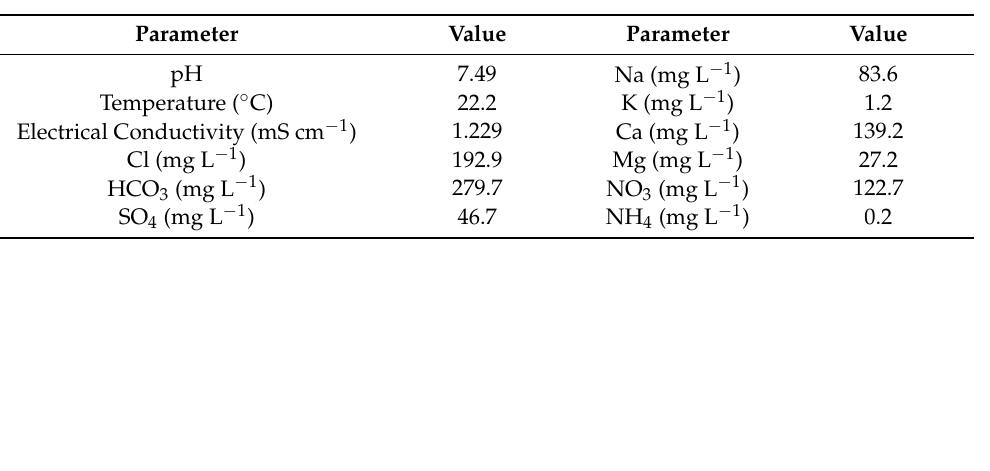
Table 3. Main physicochemical characteristics of the irrigation